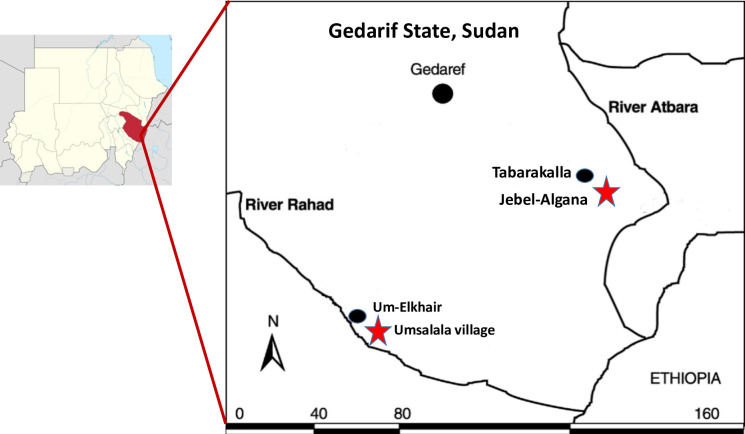
Map of Gedarif state, Sudan, showing location of Jebel-Algana and Umsalala study villages in relation to Tabarakallah and Umelkher kala azar treatment centers.